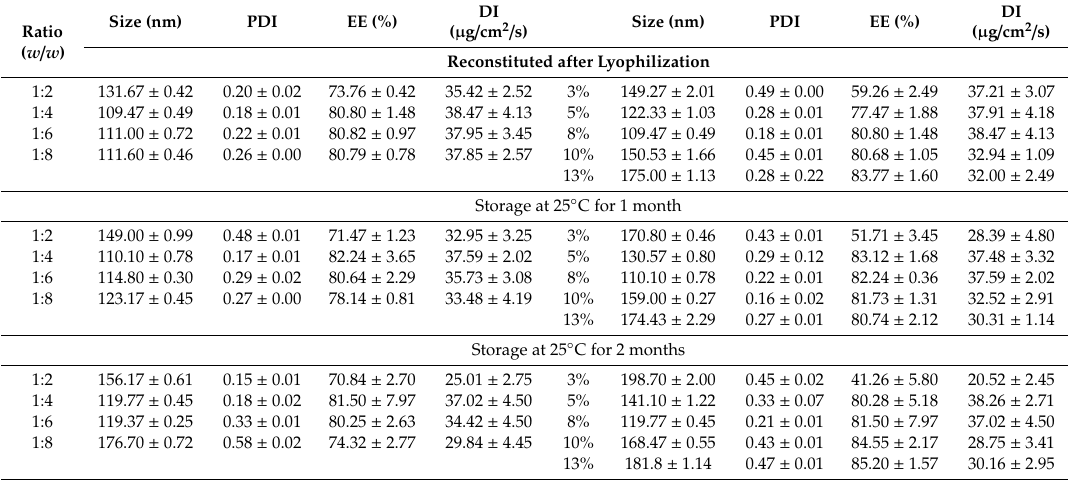
Table 4. E ff ect of di ff erent ratios and amount of lactose and trehalose on the size, PDI, entrapment e ffi ciency and deformability index of IPC-DNVs after lyophilization ( n =